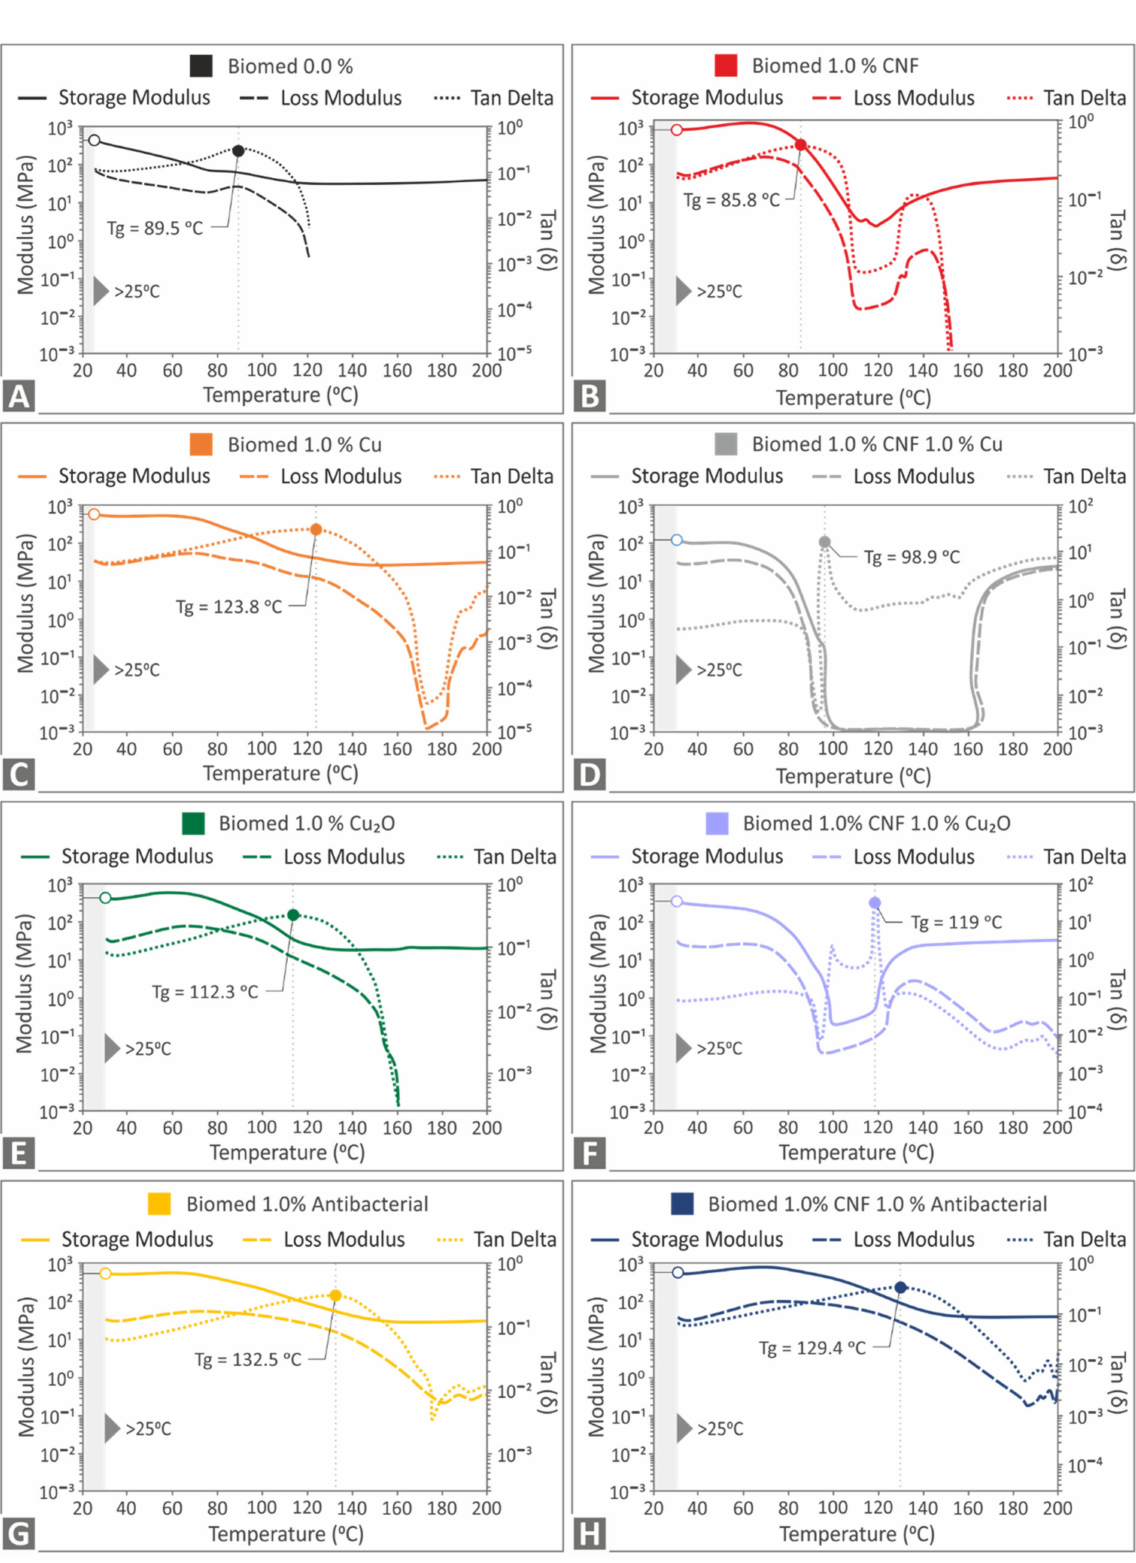
Figure 13. DMA curves: ( A ) Pure Biomed Clear, ( B ) Biomed Clear 1 wt.% CNF, ( C ) Biomed